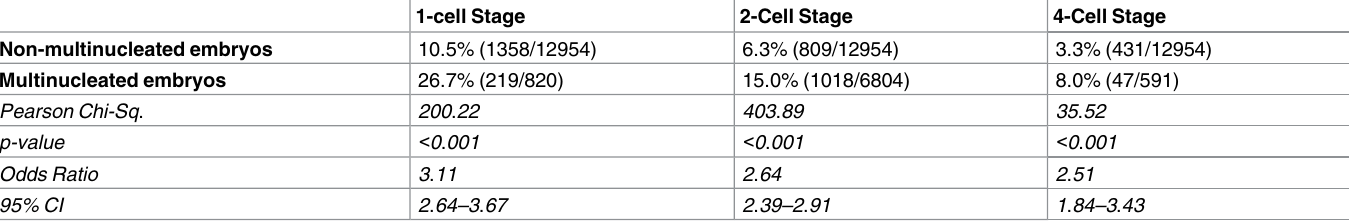
Table 2. Incidence of DUCs per embryo and multinucleation.